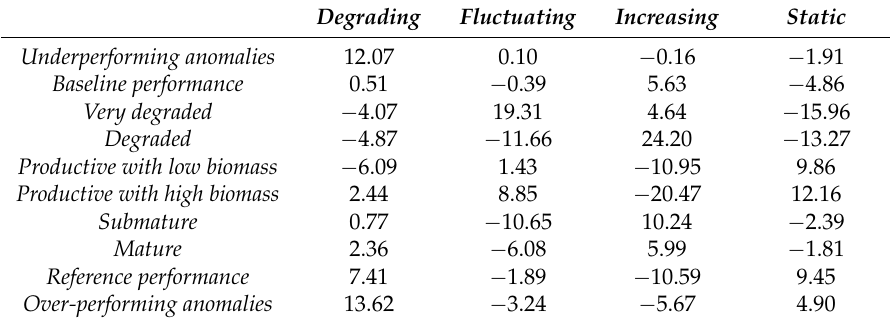
Table 2. Association of land condition states (rows) and trends (columns) found using a chi-square test ( χ 2 = 2258.77, d.f. = 27, p < 0.0001). Inputs are adjusted residuals (corrected for sample size), expressing differences between observed frequencies and expected frequencies under the null hypothesis of a random distribution. Values are standard deviation units and can be tested as z -scores using a normal distribution. A threshold of ˘ 1.96 was used to determine significance.